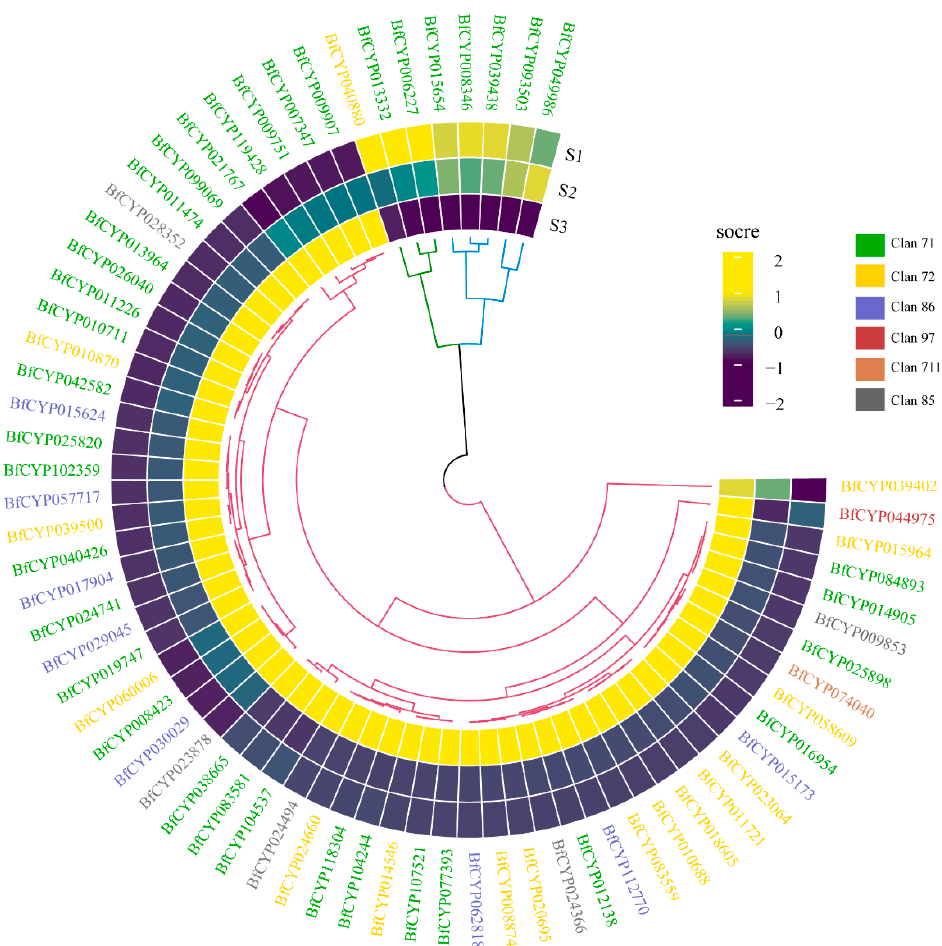
Figure 4. Gene expression profile and cluster analysis of candidate P450. These genes displayed meaningfully different expressions in S3 of B. falcatum.